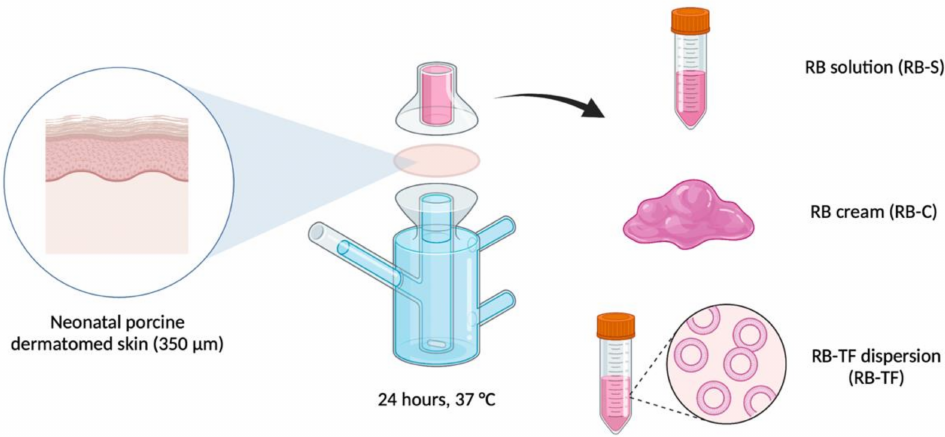
Figure 3. Schematic representation of the set-up employed for the ex vivo permeation and deposition study. RB-S: Rose Bengal solution, RB-C: Rose Bengal cream, and RB-TF: Rose Bengal